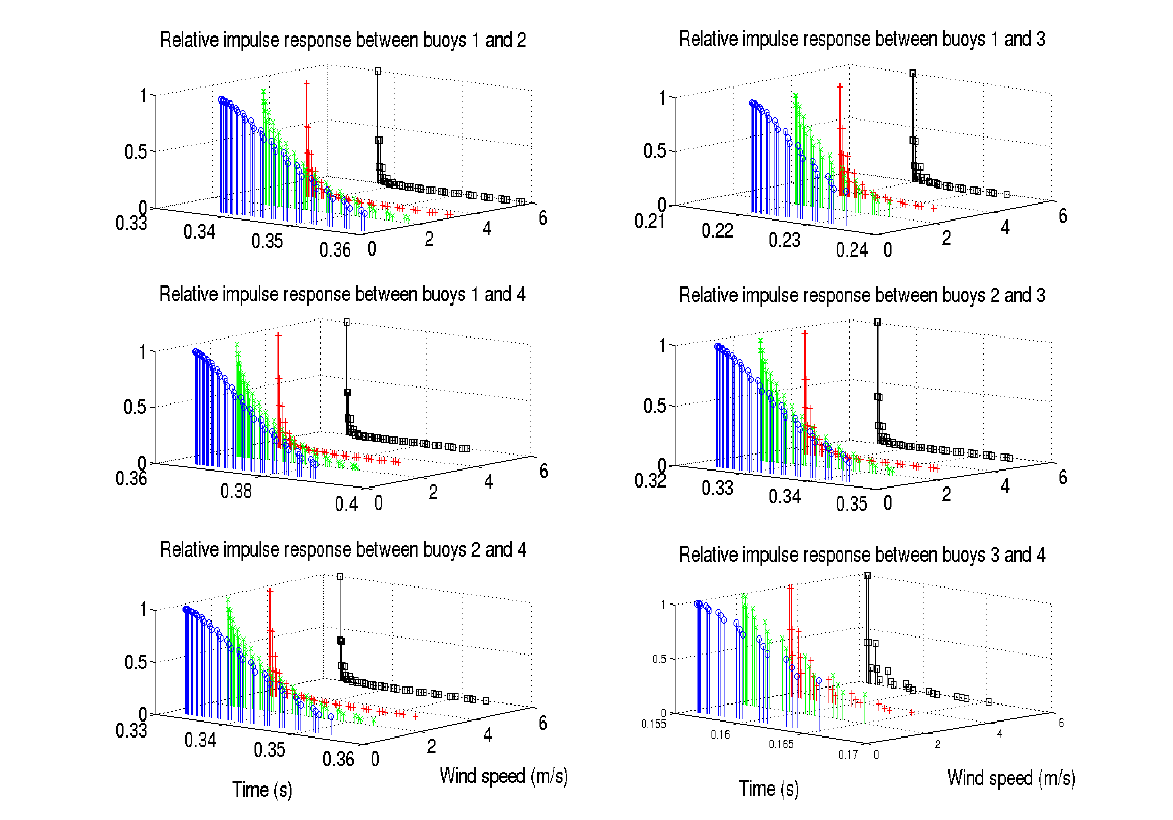
Figure 5. Dependence of the relative impulse response on wind